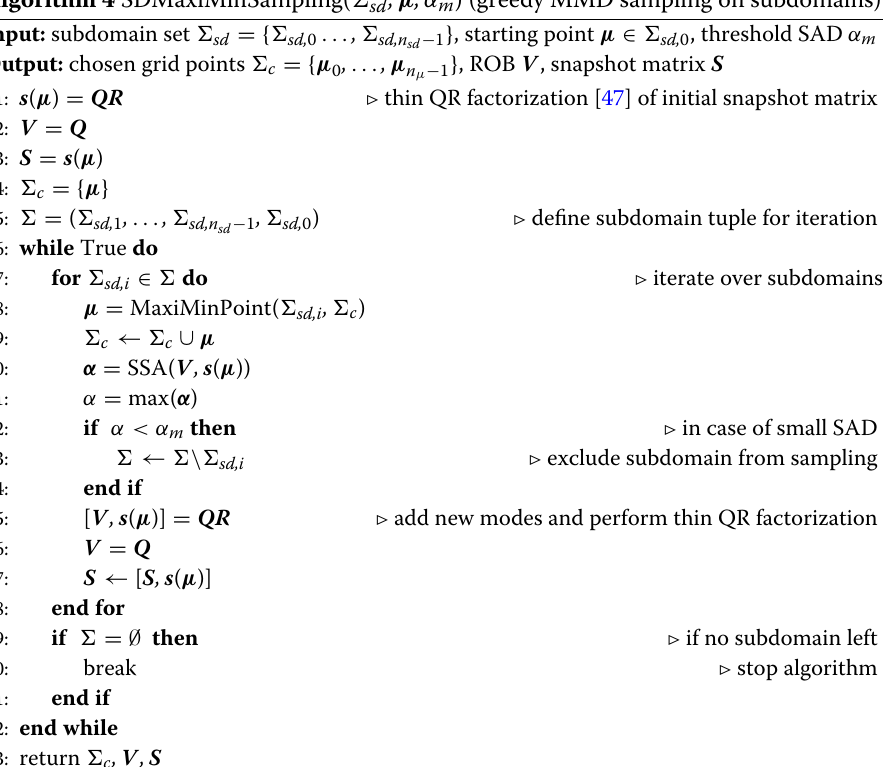
Algorithm 4 SDMaxiMinSampling( (cid:12) sd , μ , α m ) (greedy MMD sampling on subdomains)